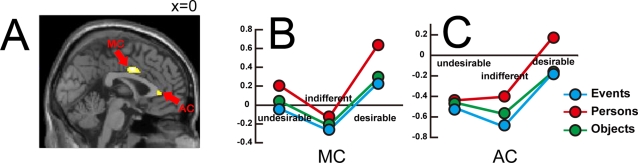
Conjunction analysis of desirable > indifferent (displayed at the threshold Puncorrected <0.001).Peak activity was located in the mid-cingulate cortex (MC above) (0, 2, 36, SVC). Another activation was in anterior cingulate cortex (AC above) (0, 34, 4 SVC). Both are shown in sagittal section (A). Parameter estimates for the three stimulus categories and for the three desirability classifications for MC (B) and for AC (C). The peak activity voxel in MC at 0, 2, 36 falls within the cluster of active voxels shown in Fig 6B which exhibit a quadratic relationship with desirability.